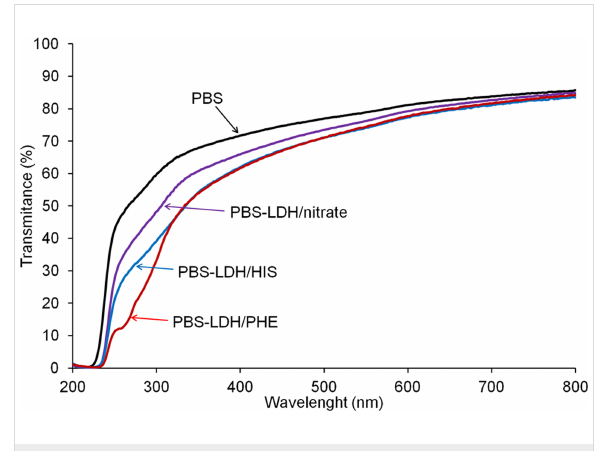
Figure 10: UV–vis transmittance spectra of PBS and PBS nanocom- posites with Mg 2 Al LDH